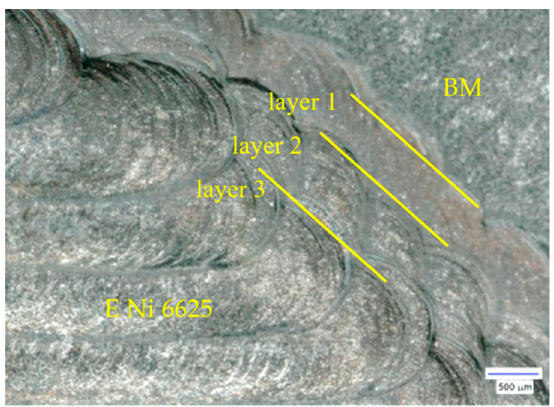
Figure 3. The appearance of the surface of the three-layer CMT welded clad E Ni 6625.